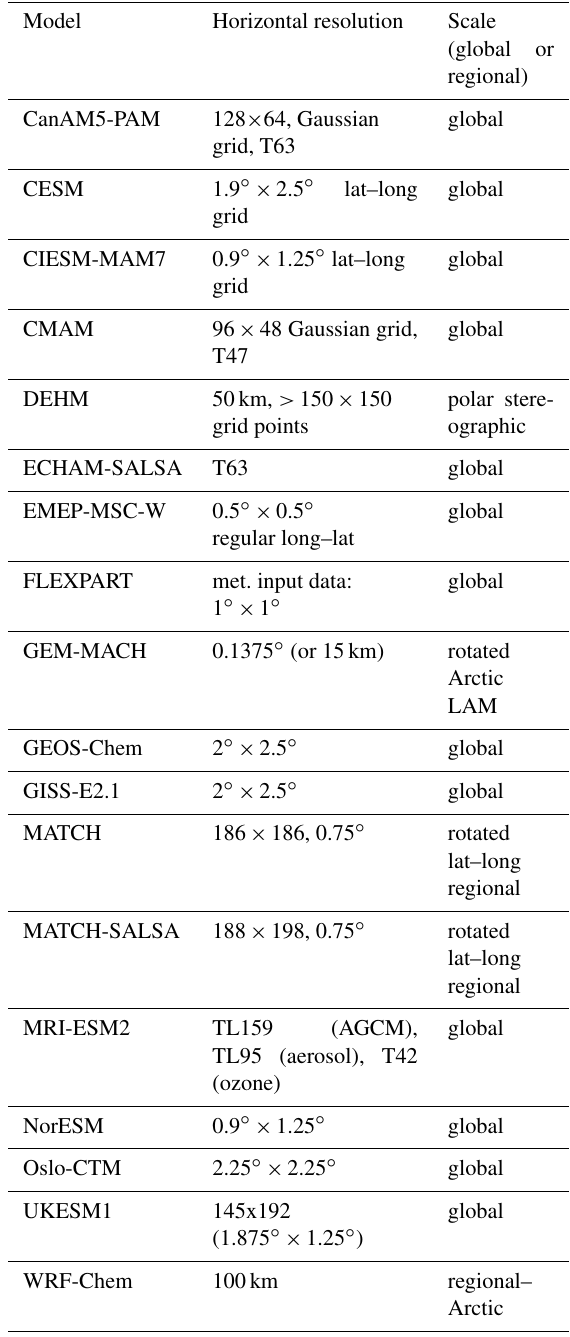
Table A1. Information about models’ spatial